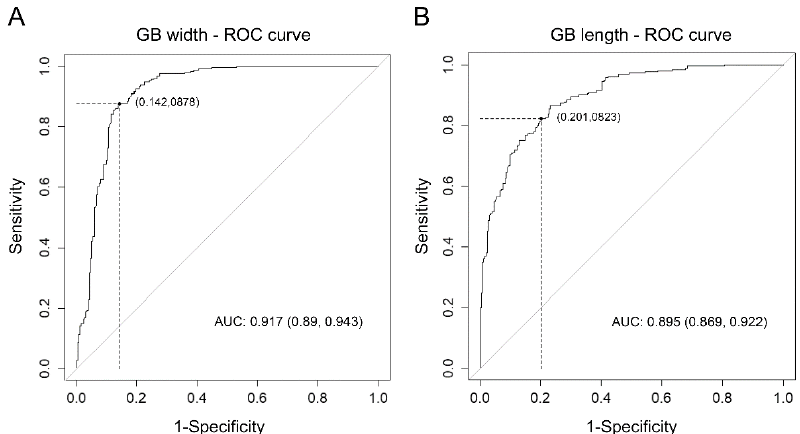
Figure 4. ( A ) The ROC curve for univariable logistic regression analysis of the association between GB width and acute cholecystitis, ( B ) ROC curve for univariable logistic regression analysis of the association between GB length and acute cholecystitis. (Abbreviations: GB, gallbladder; ROC, receiver operating characteristic; AUC, area under the curve.)